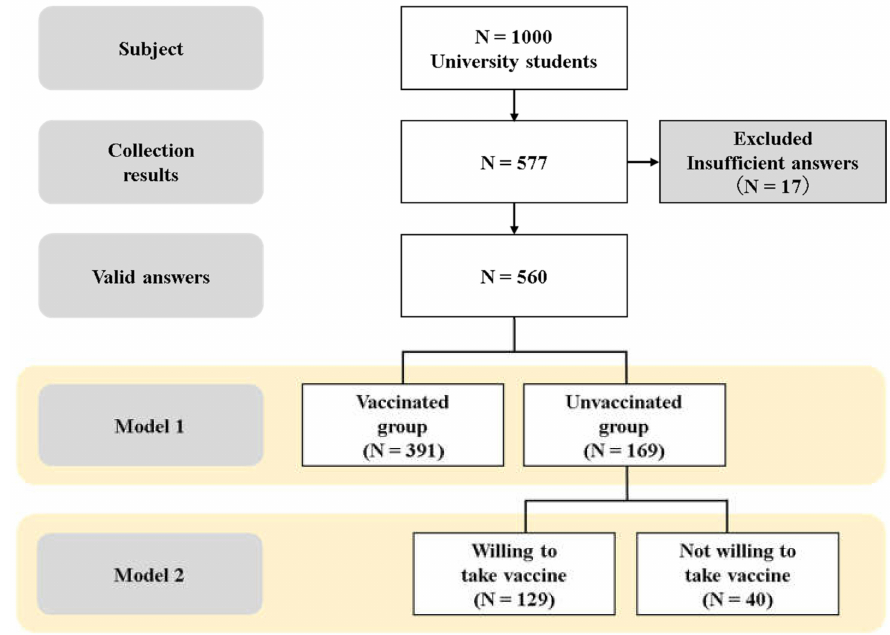
Figure 1. Flowchart of participant